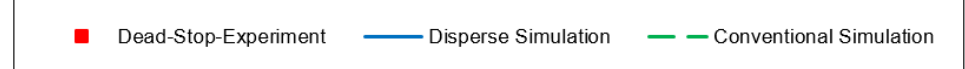
Figure A1. Comparison of the measured versus simulated solids contents for double-wave screw D = 45 mm ( a , b ) and energy-transfer screw D = 45 mm ( c , d ).